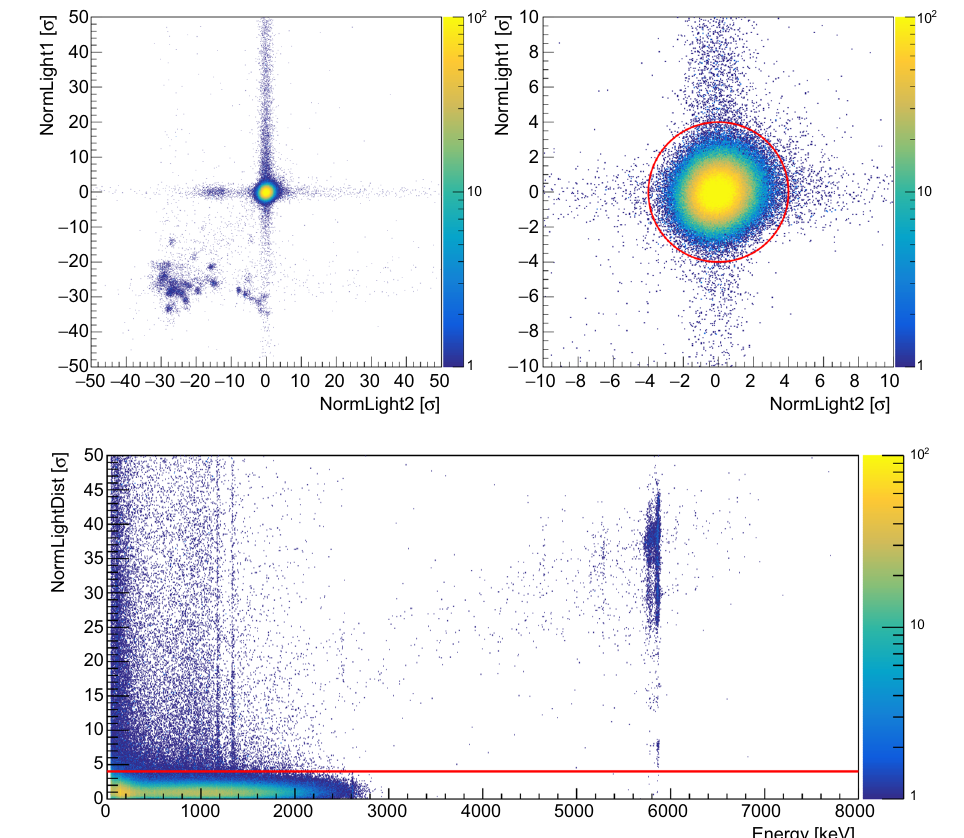
α ’s from the various detectors and show the hallmark deficiency of scintillation light on both light sensors. The energy dependence of the normalized light distance is shown in the bottom figure, again with the cut boundary denoted by a solid line. α events are clearly well separated from the β/γ ’s. We observe that the norm light distance for these events is roughly flat with energy. The contamination due to excess 60 Co on 1 LD is evident. A cluster of α events at low normalized light distance is present due to a short period of time with sub-optimal performance on a single